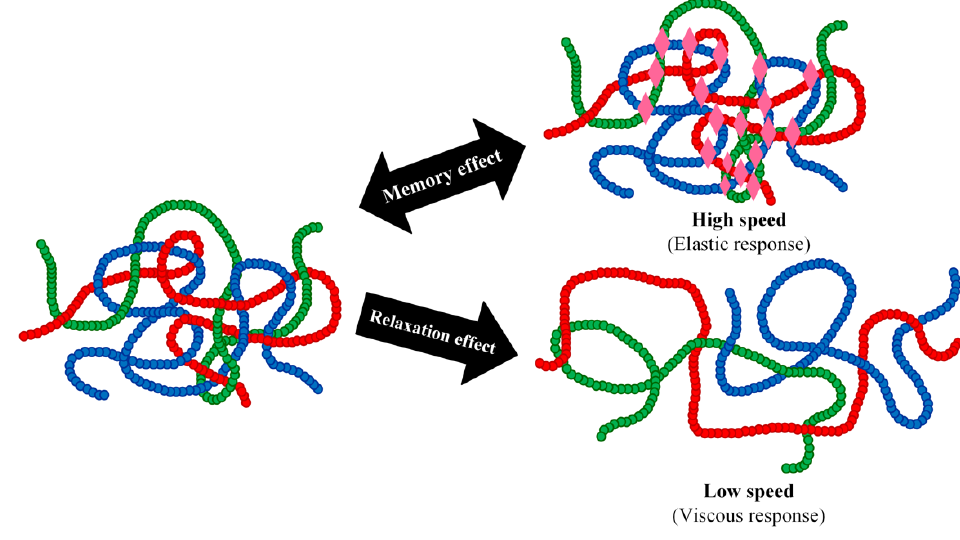
Figure 3. Entangled elastomer chains (with different colours illustrating different chains) respond to externally applied force in different ways. If we quickly stretch an elastomer, the entangled chains will make provisional knots that oppose the movement of the chains. The elastomer displays an elastic response (memory effect). On the other hand, if we slowly stretch the entangled chains, they have time to relax and restrain and rearrange themselves. The elastomer chains flow similar to a liquid, thereby showing a viscous response. Thus, the response of an elastomer to external stress is always the result of the balance between the rate of molecular agitation (which increases with high temperatures) and the rate of external stress (which increases with high frequencies or short times). These behaviours are the origin of one of the characteristic properties of polymers: the law of time–temperature